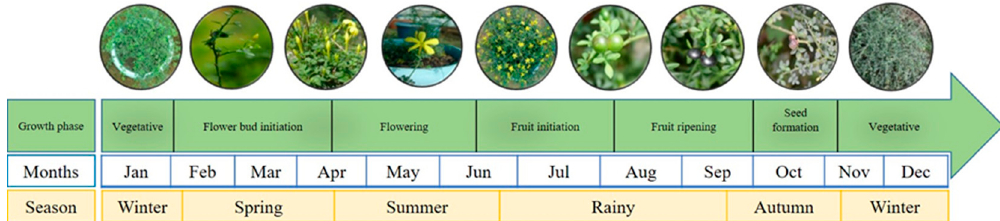
Figure 1. Phenological stages of Jasminum parkeri in a naturally ventilated polyhouse.